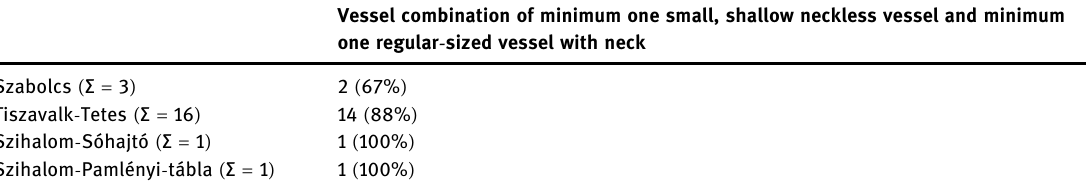
Table 8: The number of graves containing minimum one small, shallow neckless vessel and minimum one regular - sized vessel with neck at Szabolcs, Tiszavalk - Tetes, Szihalom - Sóhajtó, and Szihalom - Pamlényi - tábla Vessel combination of minimum one small, shallow neckless vessel and